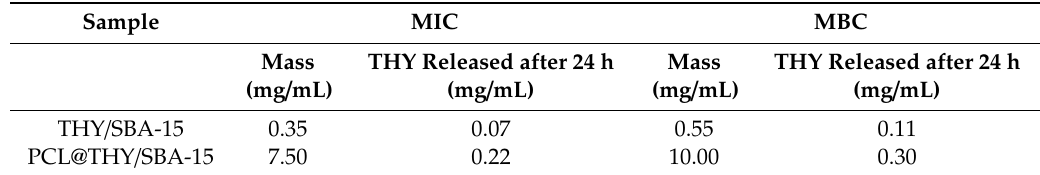
Table 2. Antimicrobial activity of prepared materials.